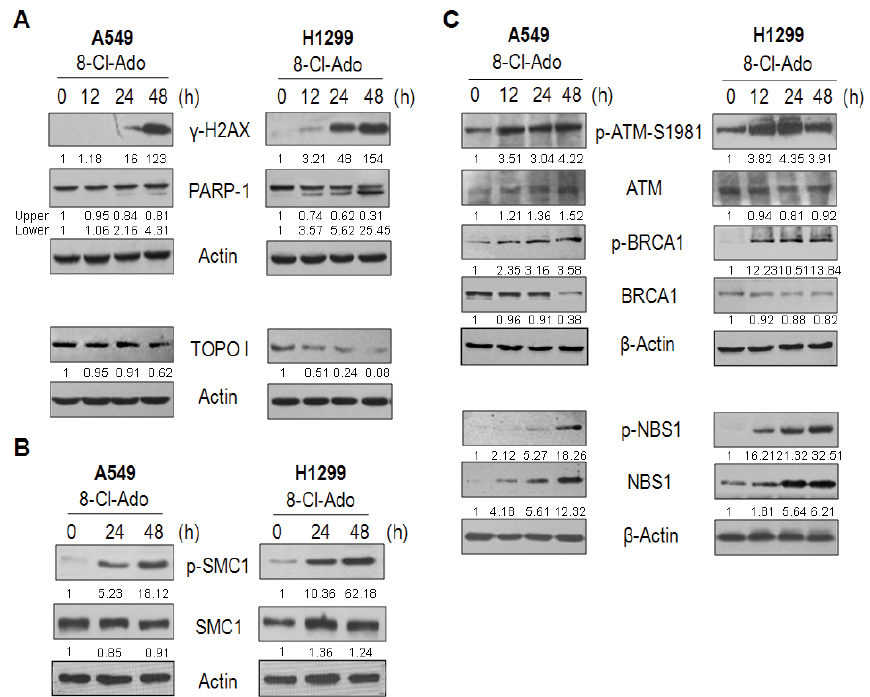
Figure 7. Western blotting for PARP-1, TOPO I and DNA responsive proteins in DDR. A549 and H1299 were exposed to 2 μ M 8-Cl-Ado for the indicated hours. The γ -H2AX, PARP-1 and TOPO I ( A ), SMC1 ( B ), ATM, BRCA1 and NBS1 and their modifications ( C ) were analyzed by Western blotting with specific antibodies. Also see Figure S1 for BRCA1/pBRCA1 full blots of A549 cells in ( C ). β -Actin as a loading control. The ratio of target protein/Actin from control cells was designated as “1”.